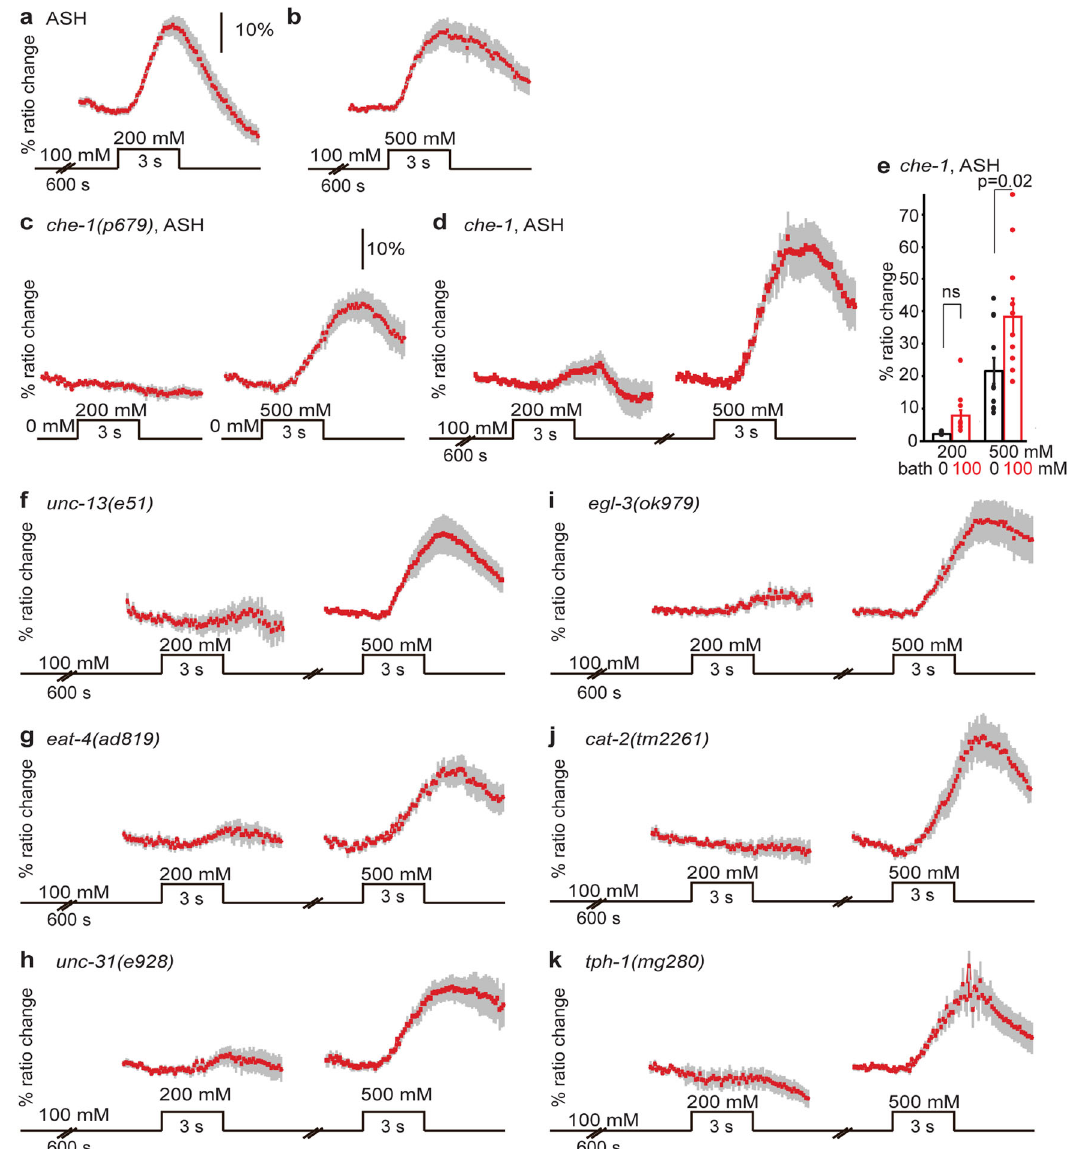
Fig. 6 ASH sensitization requires ASE, glutamate, neuropeptides, dopamine, and serotonin. a , b Average Ca 2 + transients (±SEM) in ASH neurons of wild-type animals after 600s pre-exposure to 100 mM NaCl in response to an increase to 200 ( a ) or 500 ( b ) mM NaCl (data from Fig. 4). c Average Ca 2 + transients (±SEM) in ASH neurons of che-1(p679) animals in response to exposure to 200 or 500 mM NaCl. Naïve che-1 animals did not respond to 200 mM NaCl ( n = 6 animals) but did respond to 500 mM ( n = 11). d Average Ca 2 + transients (±SEM) in ASH neurons of che-1(p679) animals after 600 s pre-exposure to 100 mM NaCl in response to an increase to 200 or 500 mM NaCl. Only very weak responses to 200 mM NaCl could be observed in che-1 animals ( n = 11, 3 out of 11 worms showed a response). The same che-1 animals did respond to 500 mM NaCl after a 2 min wash ( n = 11). e Average maximum ratio changes (±SEM) in ASH of che-1 mutant animals after exposure to 200 or 500 mM NaCl, in animals pre-exposed to 100 mM NaCl for 600 s, or to control condition (100 or 0 mM NaCl bath solution, respectively). Individual data points have been indicated as dots. f – k Average Ca 2 + transients (±SEM) in ASH neurons of various neurotransmitter mutants after 600 s pre-exposure to 100 mM NaCl in response to an increase to 200 and subsequently 500 mM NaCl. None of these mutants showed a signi fi cantly stronger response to 200 mM NaCl after pre-exposure than in the naïve situation ( p > 0.05). Only responses of animals that responded to 500 mM NaCl were included. f Two out of eight unc-13(e51) animals that responded to 500 mM NaCl responded to 200 mM NaCl after pre-exposure to 100 mM NaCl. g Two out of nine eat-4(ad819) animals that responded to 500 mM NaCl responded to 200 mM NaCl after pre-exposure to 100 mM NaCl. h Three out of seven unc-31(e928) animals that responded to 500 mM NaCl responded to 200 mM NaCl after pre-exposure to 100 mM NaCl. i Three out of nine egl-3(ok979) animals that responded to 500 mM NaCl responded to 200 mM NaCl after pre-exposure to 100 mM NaCl. j Three out of nine cat-2(tm2261) animals that responded to 500 mM NaCl responded to 200 mM NaCl after pre-exposure to 100 mM NaCl. k One out of eight tph-1(mg280) animals that responded to 500 mM NaCl responded to 200 mM NaCl after pre-exposure to 100 mM NaCl. Statistically signi fi cant differences have been indicated. Source data underlying this fi gure are available in Supplementary Data